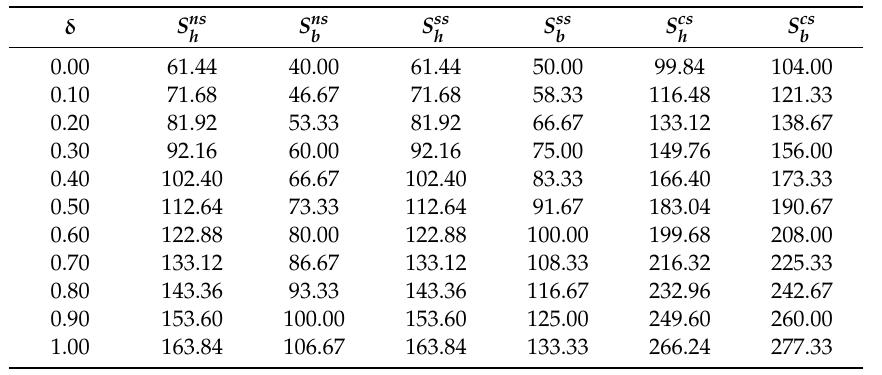
Table 4. Medical insurance reimbursement for superior and subordinate hospital under di ff erent reference price e ff ects.